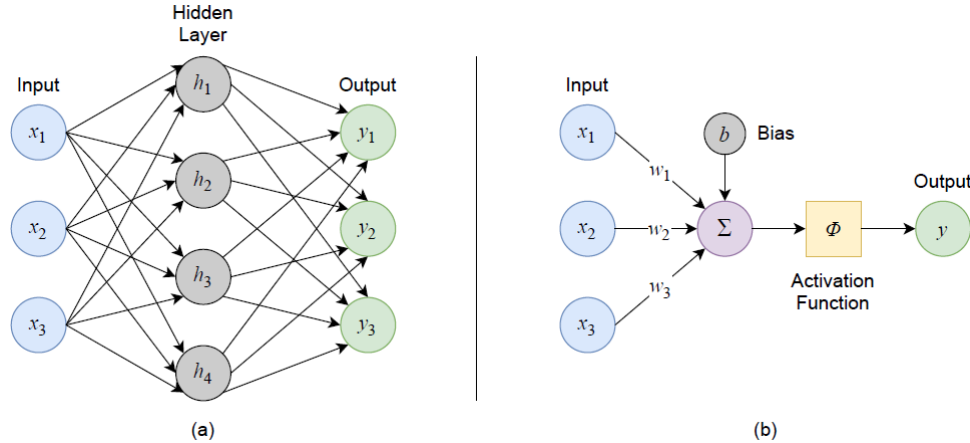
Figure A2. Schematic diagrams of a feed-forward artificial neural network at the ( a ) model architec- ture and ( b ) neuron levels (modified after [74]).